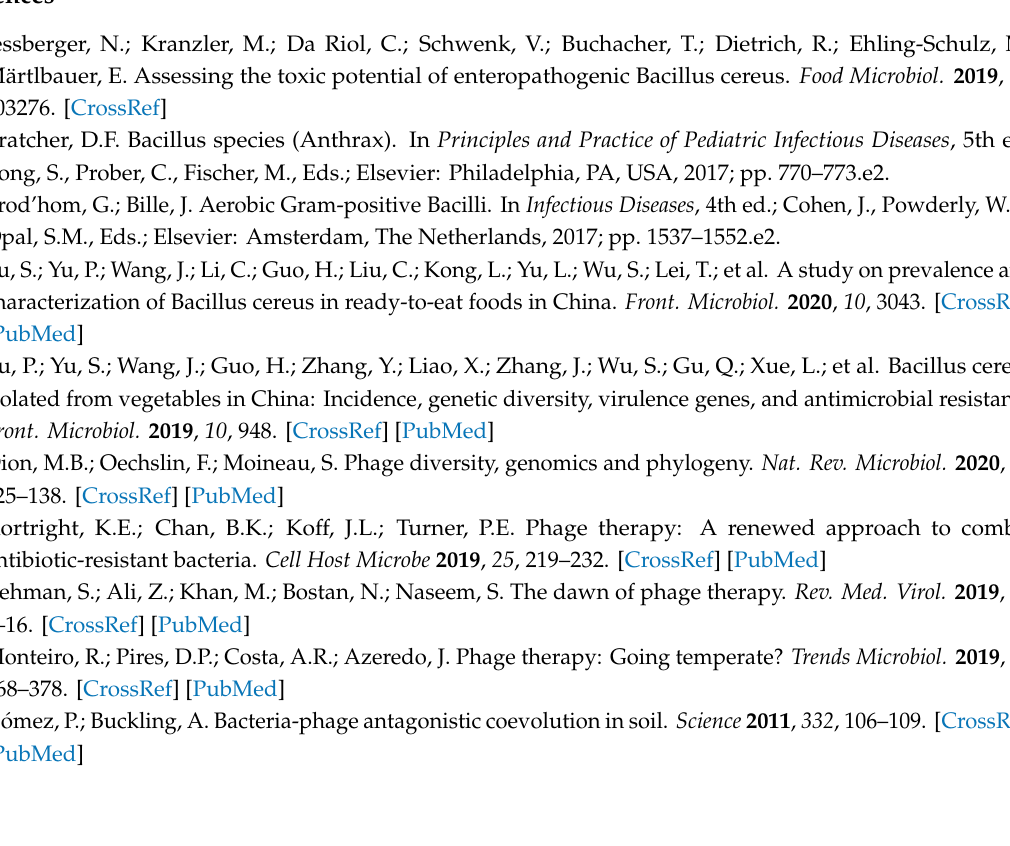
Figure S1: Sanger sequencing chromatogram of the genome ends of DLc1 verified the 5 bp inverted terminal repeats (5 (cid:48) AAATG in left end (A) and 3 (cid:48) TTTAC in right end (B); Figure S2: Phylogenetic tree of the ϕ 29-like phages and other members in the current Picovirinae subfamily, constructed with the genes encoding pre-neck appendage protein (A) and endolysin (B), respectively; Figure S3: The linear fitting results of three independent adsorption rate constant determinations; Figure S4: Imaging the adsorption of DLc1 onto B. cereus 1582-3B at an MOI added of 100 after di ff erent treatments by TEM; Table S1: The viruses used for genome alignment; Table S2: The predicted position of pro-head RNA; Table S3: The predicted functions of ORFs in DLc1 and the similarities of di ff erent ORFs to those of phage ϕ 29; Table S4: The Hadamard matrix derived from the ANIm and ANIb alignment method; Table S5: The blastn results in NCBI and the nucleotide identity of DLc1 to its